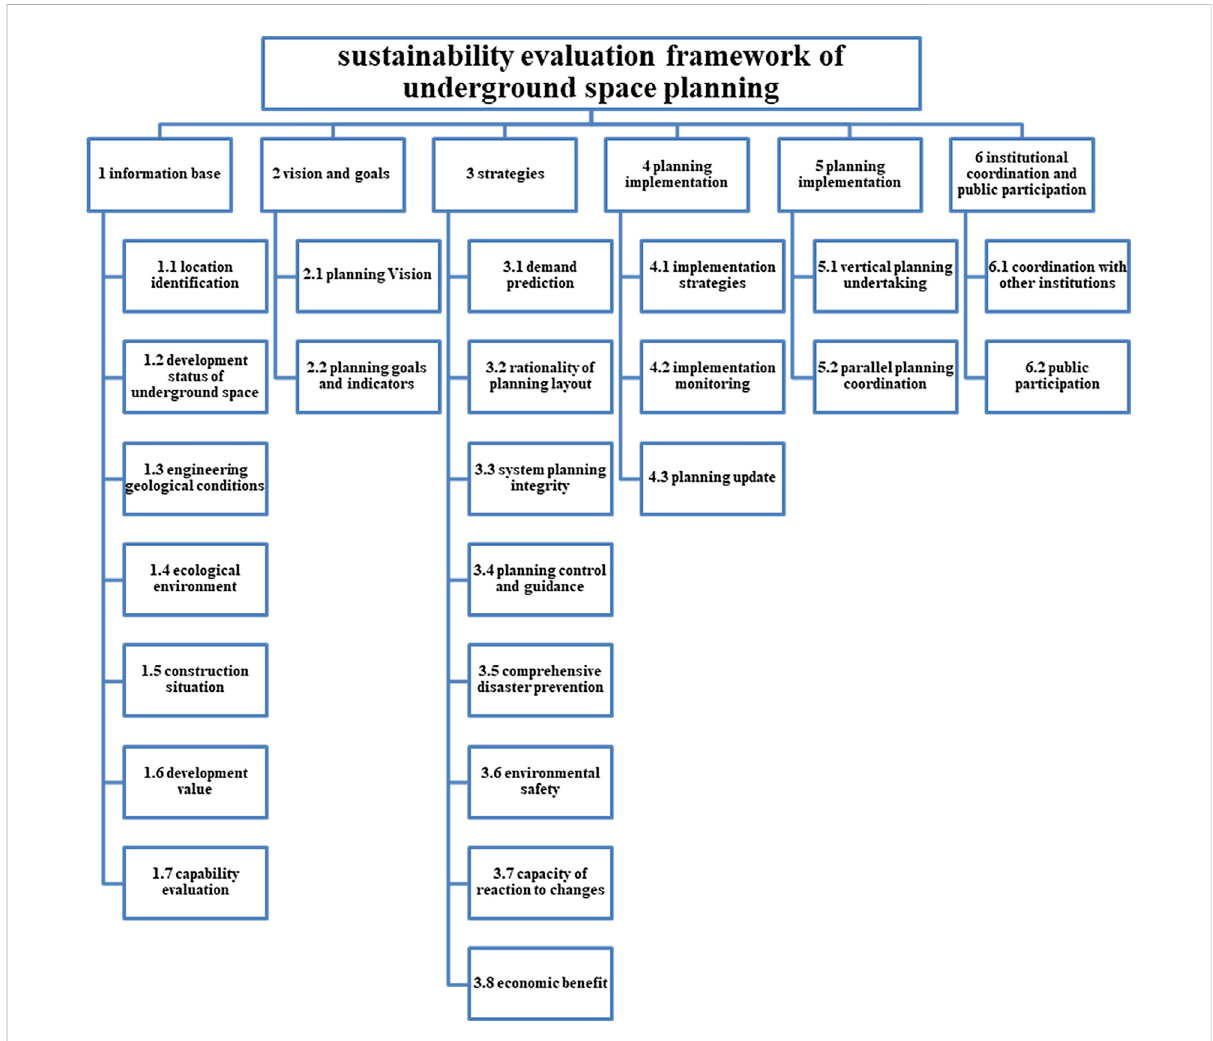
FIGURE 1 Sustainability evaluation framework of underground space